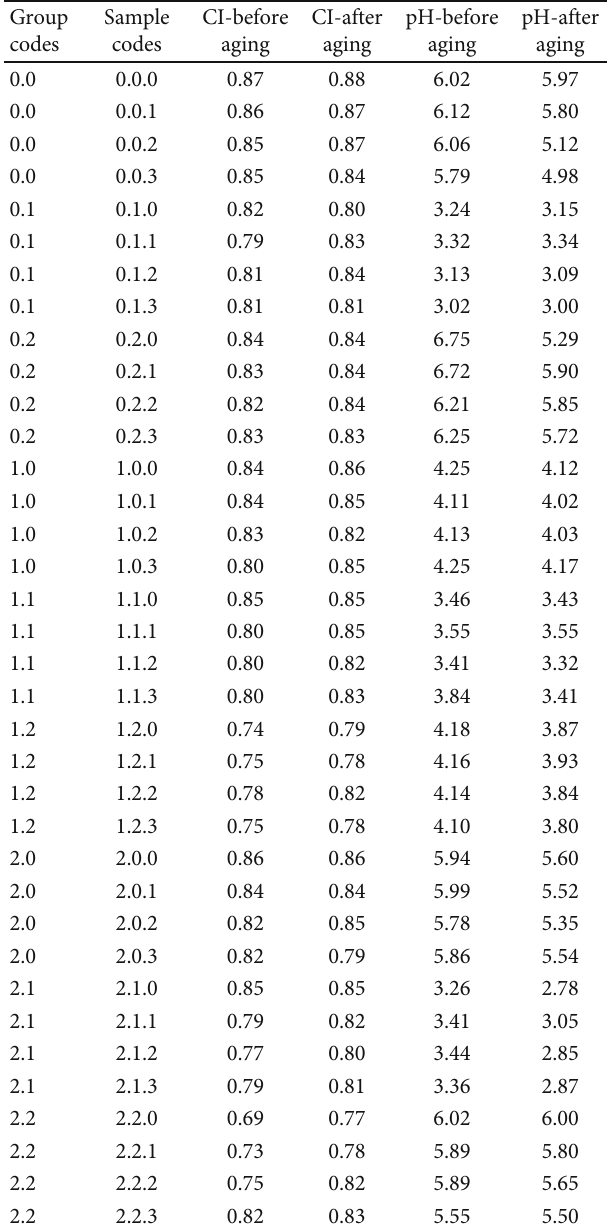
Table 2: Crystallinity index ( CI ) and pH of test specimens with sample and group codes before and after thermal aging. Group Sample CI-before CI-after pH-before pH-after codes codes aging aging aging